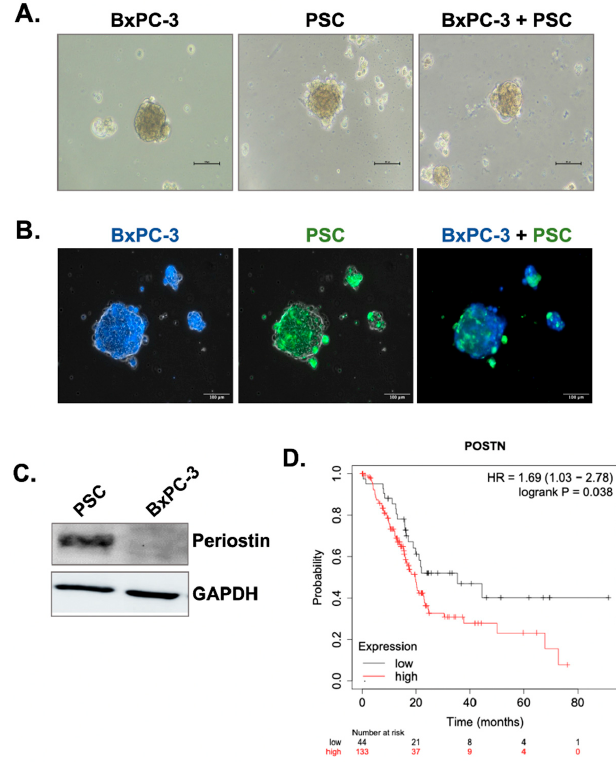
Figure 1. Periostin is specifically produced by PSCs and its overexpression is related poor prognosis in PDAC patients. ( A ) BxPC ‐ 3 cells were co ‐ cultured with PSCs in poly ‐ HEMA coated plates to form spheroids. The images were taken 4 days after seeding. ( B ) To show heterotypic cell ‐ cell interactions in the same spheroid, BxPC ‐ 3 cells and PSC cells were labeled with CellTracker blue and green, respectively. The images represent the same spheroid area captured by specific filters for blue and green dyes and then merged. ( C ) Western blot analysis of periostin expression in BxPC ‐ 3 pancreatic cancer cells and PSCs. GAPDH was used as the loading control. ( D ) Kaplan ‐ Meier survival analysis of PDAC patients with low and high periostin mRNA expression ( p = 0.038).